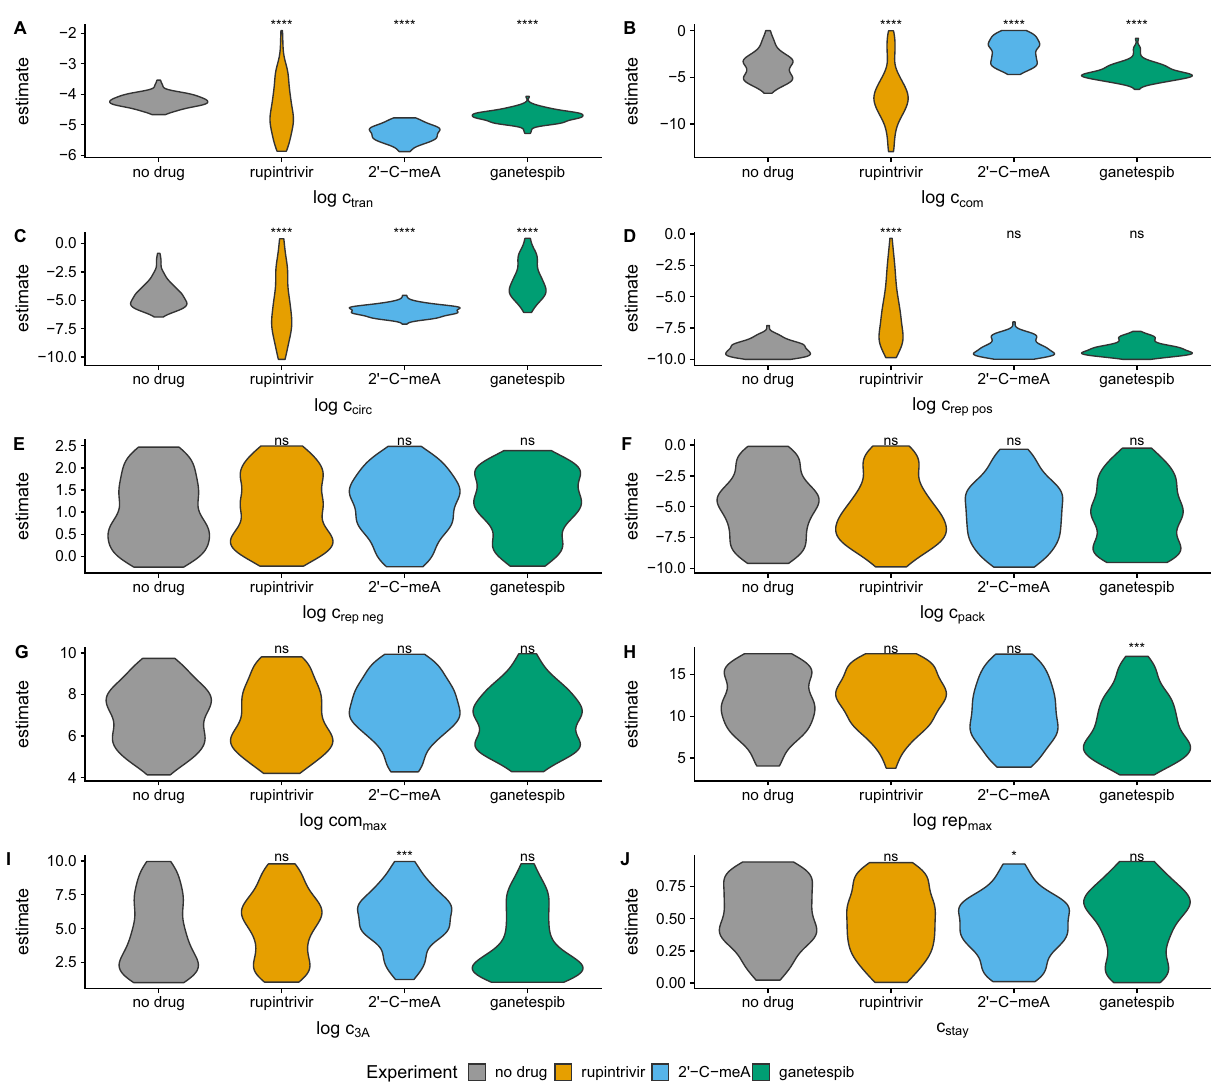
Figure 6. Comparison of posterior parameter distributions between the no drug treatment and drug treatments. Asterisks indicate distributions that differ significantly from the no drug treatment after Bonferroni correction for multiple testing. Non significant (ns) corresponds to p > 0.05 , a single asterisk corresponds to p ≤ 0.05, two asterisks correspond to p ≤ 0.01, three correspond to p ≤ 0.001, and four correspond to p ≤ 0.0001 from a K-S test. Parameters are estimated by fitting the model described by the equations in Table 1 and illustrated in Fig. 2A. Parameters correspond to those labeled in each reaction. ( A ) Translation, which occurs in step 3 of the model. ( B ) Compartmentalization, a part of step 4. ( C ) Circularization, step 5. ( D , E ) Replication of positive and negative sense RNA, step 6. ( F ) Packaging, step 7. ( G ) The maximum number of compartments possible, considered in step 6. ( H ) The maximum number of replication cycles permitted by cellular resources, a limiting factor in step 4. ( I ) Consumption of the protein product 3 A , step 4. ( J ) The probability for a newly synthesized genome to stay in the replication complex, step